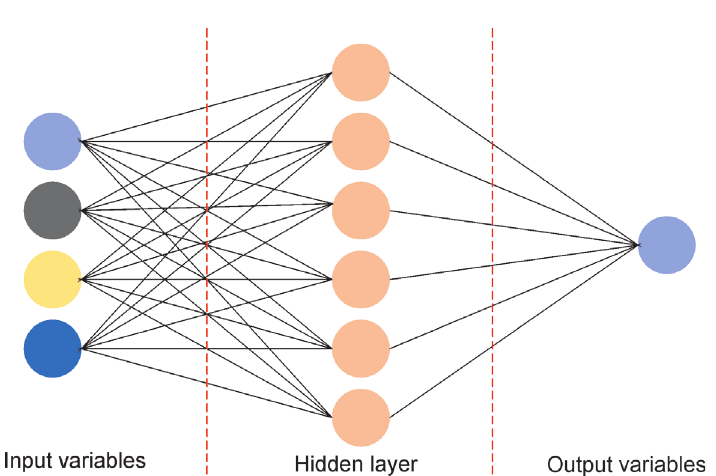
Figure 1. Artificial neuron.